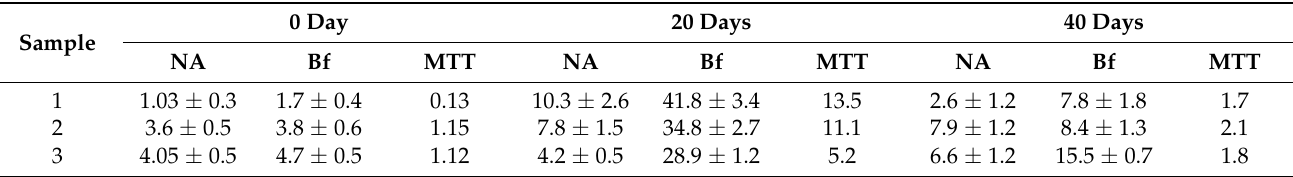
Table 6. Biofilm formation kinetics on rock samples (NA—nucleic acid area, %; Bf—common biofilm area on sand, %; MTT—sand-attached microbiota metabolic activity per